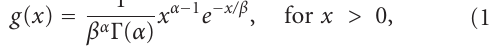
Table 1 below indicates SPI drought